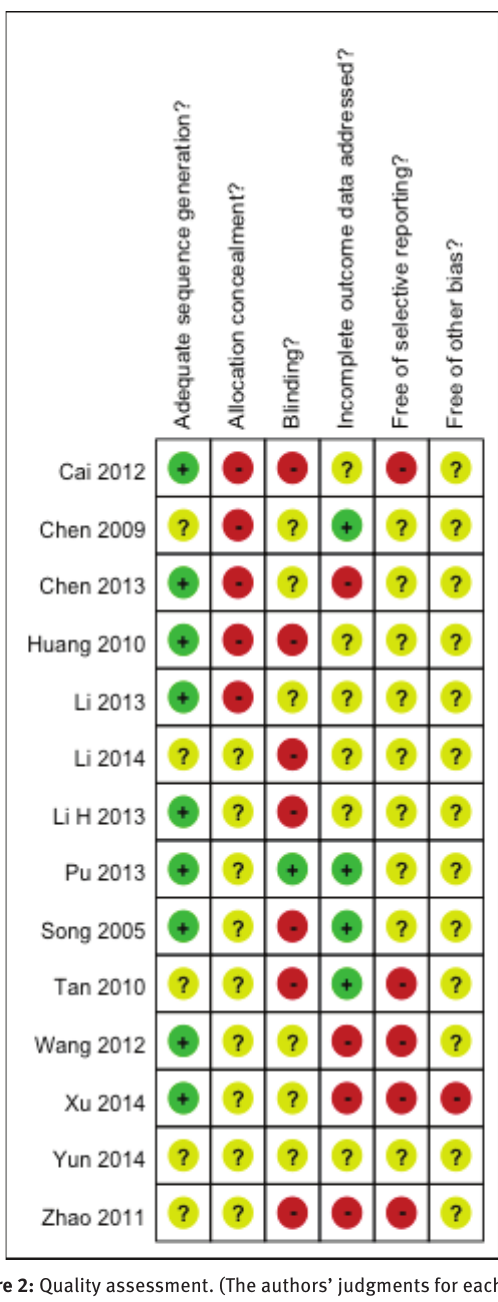
Figure 2: Quality assessment. (The authors’ judgments for each risk of bias item. + indicates low risk, - high risk, ? moderate risk.